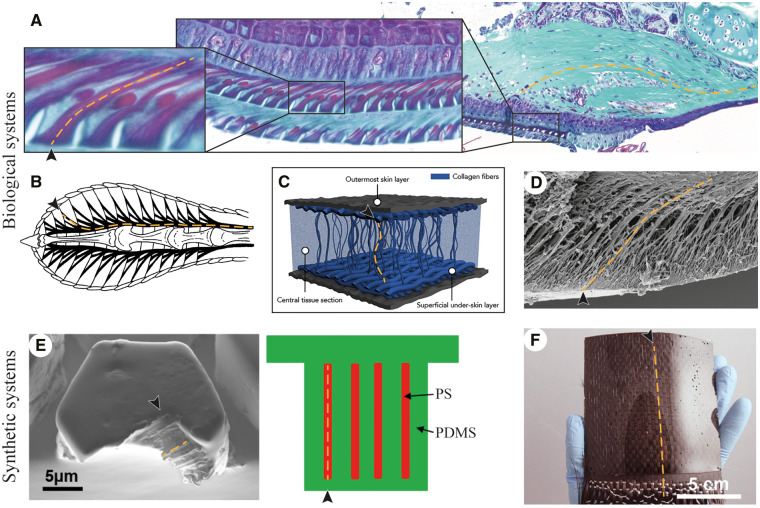
Biological (A–D) and synthetic (E–F) adhesives with internal fiber-reinforcements connecting the contact surface (arrowhead) with deeper regions of the respective system (yellow dashed line). (A) Keratinous tonofilaments (left) and collagenous fibers (right) in the toe pad of the tree frog Hyla cinerea (modified after Langowski et al. 2018b). (B) Network of tendons in the toe pad of the gecko Gekko gecko (modified after Russell 1975). (C) Collagen fibers in the suction disc of the remora fish (modified after Su et al. 2020). (D) Cuticular fibrils in the adhesive pad of the stick insect Carausius morosus (modified after Dirks et al. 2012). (E) Synthetic micropillars with embedded nanofibers in top view (left) and in schematic lateral section (right; modified after Xue et al. 2017). (F) Smooth polymer surface with underlying carbon fiber fabric (Bartlett et al. 2012b). All panels reproduced with permission.